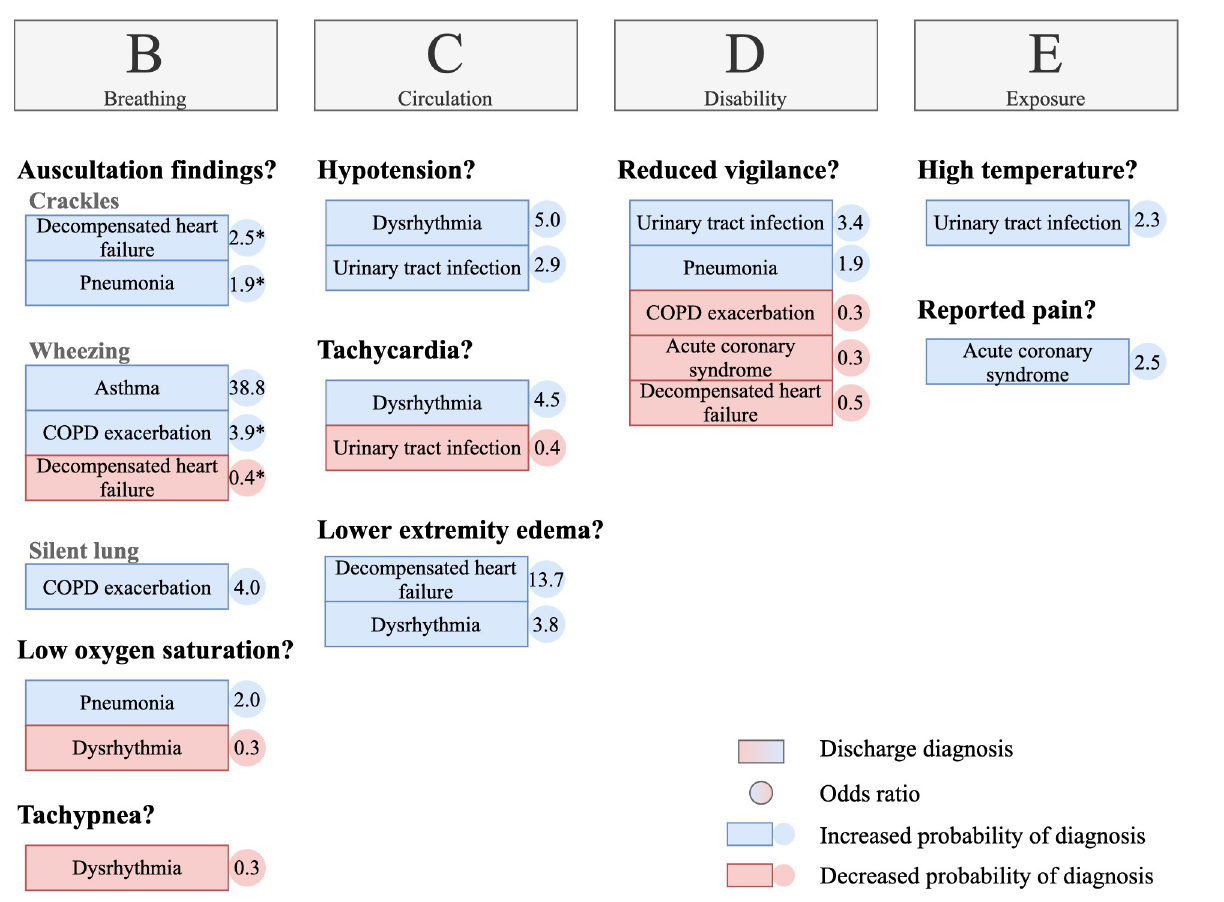
Fig 4. Associations of initial examination findings and discharge diagnoses. Binary logistic regression; only significant results are displayed, � mean of the odds ratios (when identical auscultation findings in the out-of-hospital setting and in the emergency department yielded significant results). The following variables were reviewed for associations with discharge diagnoses: out-of-hospital findings: hypotension (systolic blood pressure < 100 mmHg), tachycardia (heart rate > 100/min), low oxygen saturation (peripheral oxygen saturation < 90%), tachypnea (respiratory rate � 22/min), high temperature (body temperature � 38˚C), body temperature � 36˚C, reduced vigilance (Glasgow Coma Scale < 15), reported pain (numeric rating scale � 1), crackles upon auscultation, wheezing upon auscultation, emergency department findings: crackles upon auscultation, wheezing upon auscultation, silent lung upon auscultation, and lower extremity edema. Detailed results of logistic regressions are shown in S2